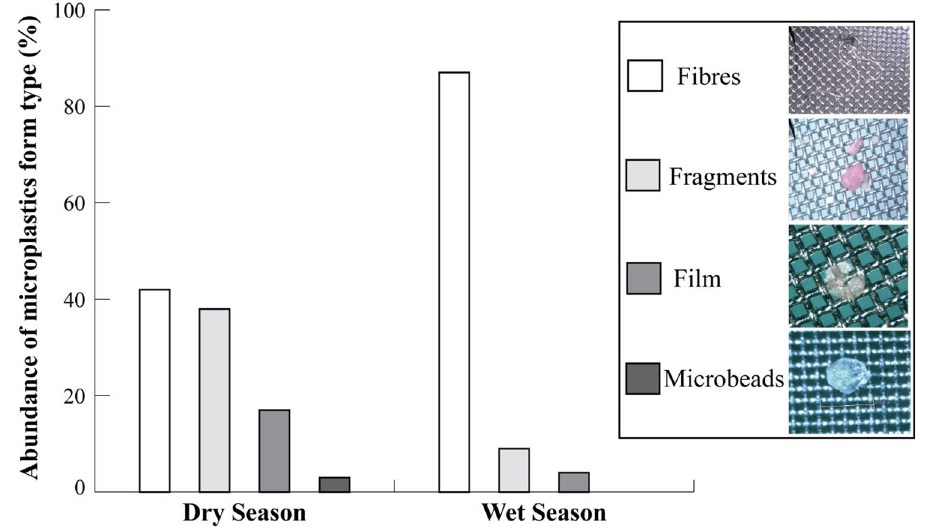
Figure 2. Form types of microplastic pieces found in the gastrointestinal system of thumbprint emperor sampled at Vueti Navakavu LMMA in the dry (N = 103 MPs) and wet (N = 103 MPs) seasons in